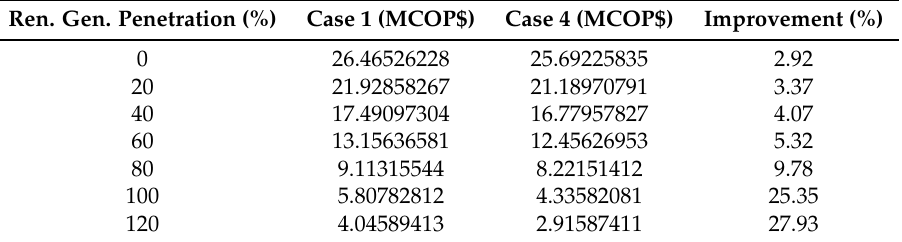
Table 6. Energy purchasing cost considering simulation C 4 and different levels of renewable generation availability compared with C 1